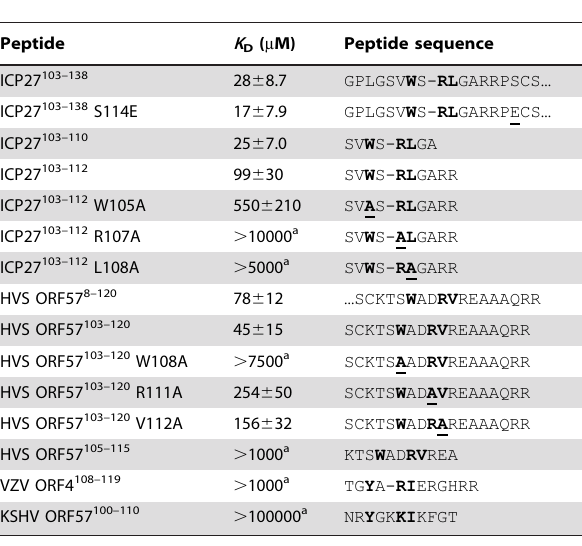
R111A + V112A and R119A + R120A, and also W108A + R111A + V112A, all substantially reduced the efficiency of the mRNA cytoplasmic accumulation. In addition, mutations of residues outside the primary REF-binding site were tested. Table 2. Dissociation constants for the interaction of REF 54–155 with viral protein